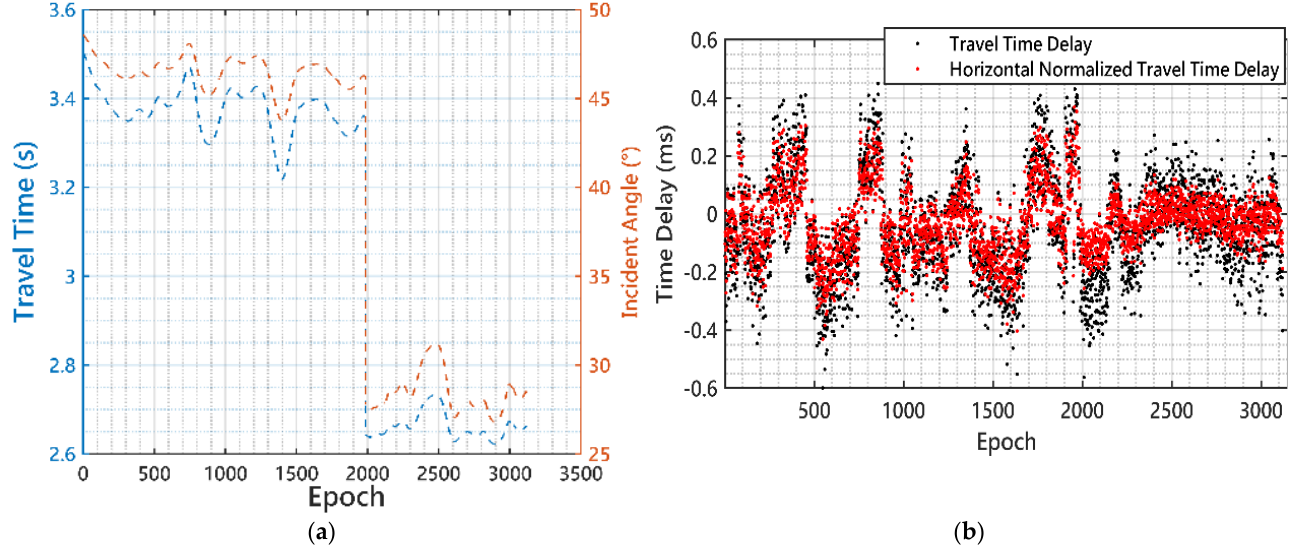
Figure 9. The acoustic round-trip travel time and incident angle of the circle line ( a ). The travel time delay and horizontal normalized travel time delay of the circle line ( b ).